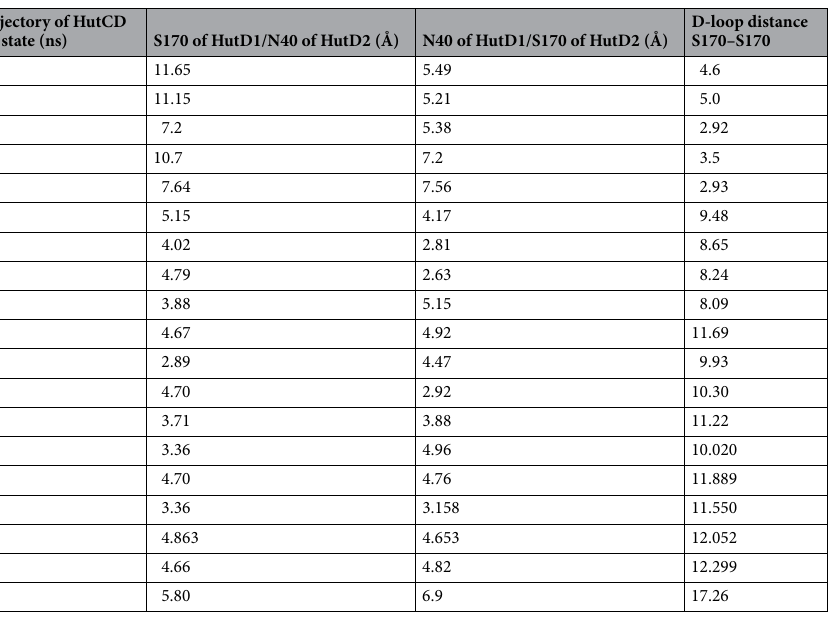
Table 1. Random frames taken in order to see any proximities between S170 of HutD1:N40 of HutD2, N40 of HutD1:S170 of HutD2 and S170 of HutD1:S170